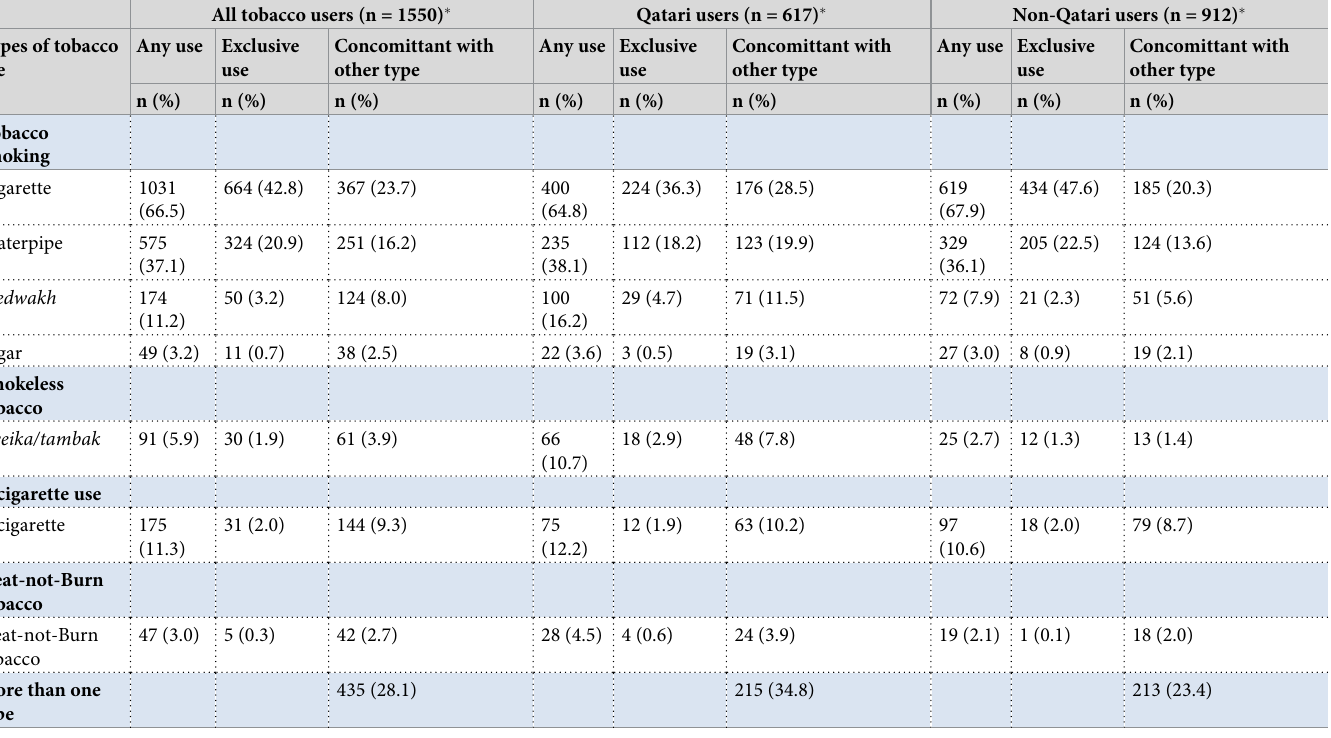
Table 3. The number and percentage of different types of current tobacco use by nationality (n, %) smoking refers to tobacco smoking (cigarettes, waterpipe, med- wakh and